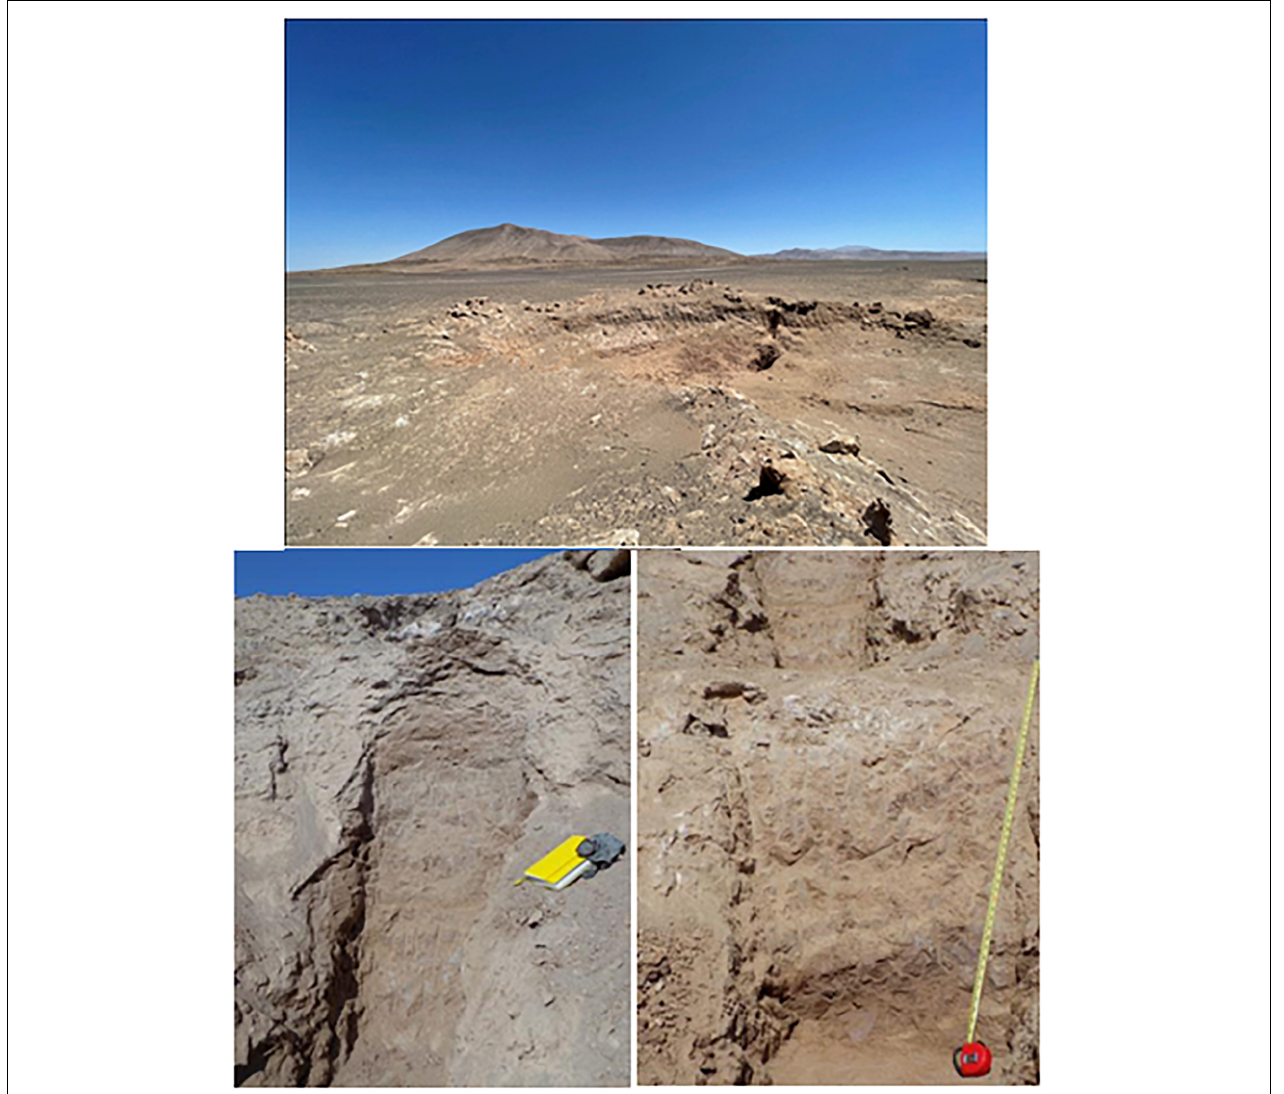
FIGURE 2 | Images of soil sampling site in Yungay hyperarid core, Atacama